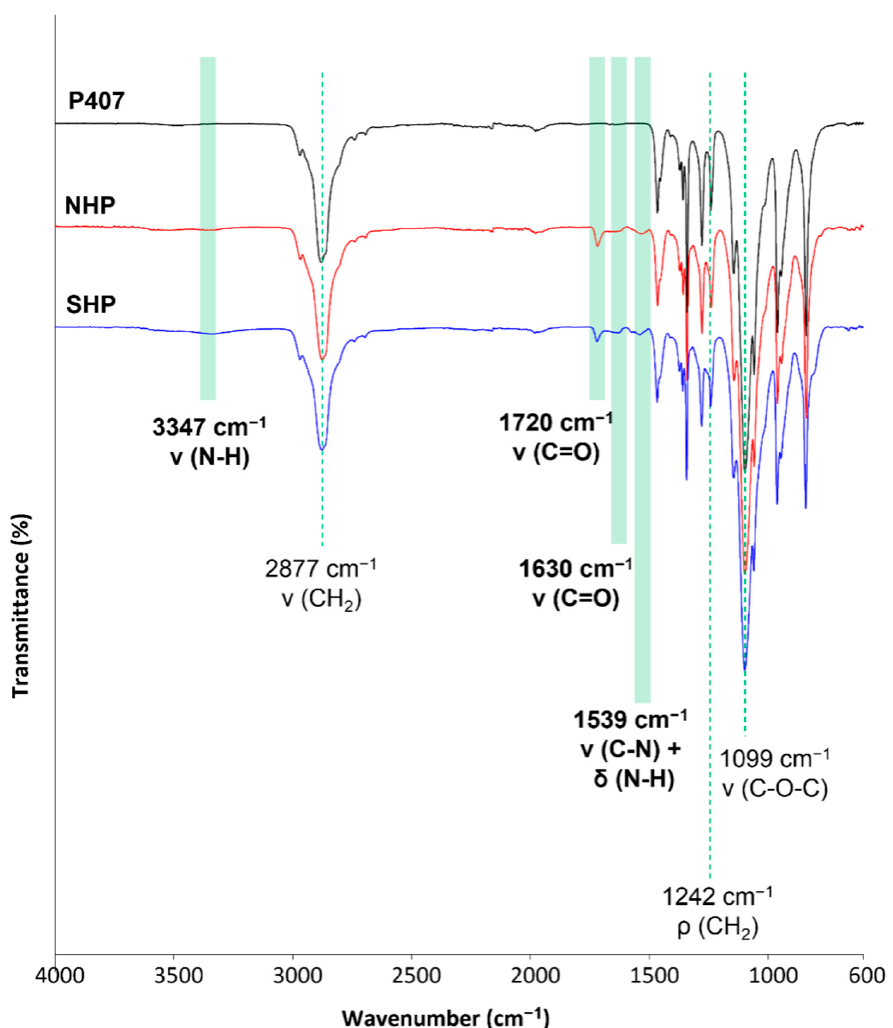
Figure 2. ATR-FTIR spectra of P407 (black), NHP (red) and SHP (blue). Light-green bars in the figure highlight the newly appeared peaks in the PEU spectra compared to the P407 one.